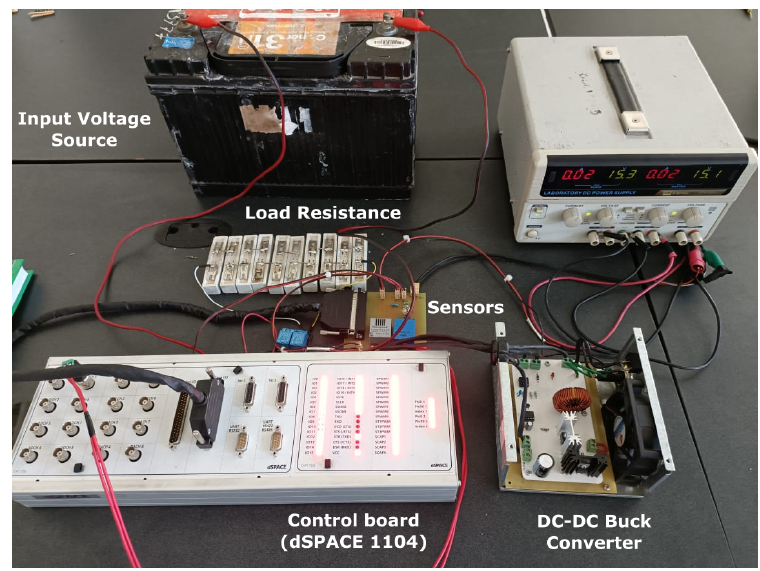
Figure 3. Experimental hardware